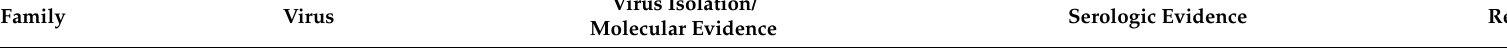
Table 1. Table describing species with published results describing virus isolation, molecular evidence, or seroconversion to species in family Bunyavirales .